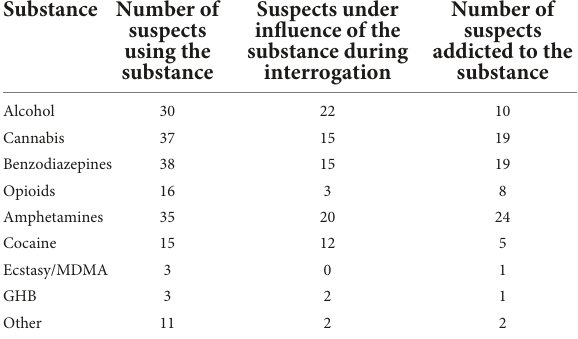
TABLE 3 Table of substances and prevalence of intoxication and substance abuse in Study 2 ( N = 97). Substance Number of suspects using the